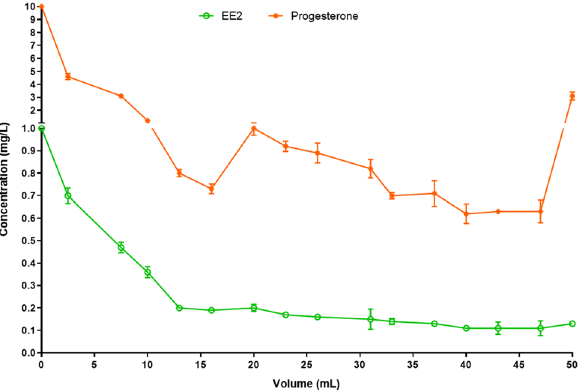
Figure 4. Breakthrough curves of the pyrolyzed biochar for 17α-ethinylestradiol (EE2) and